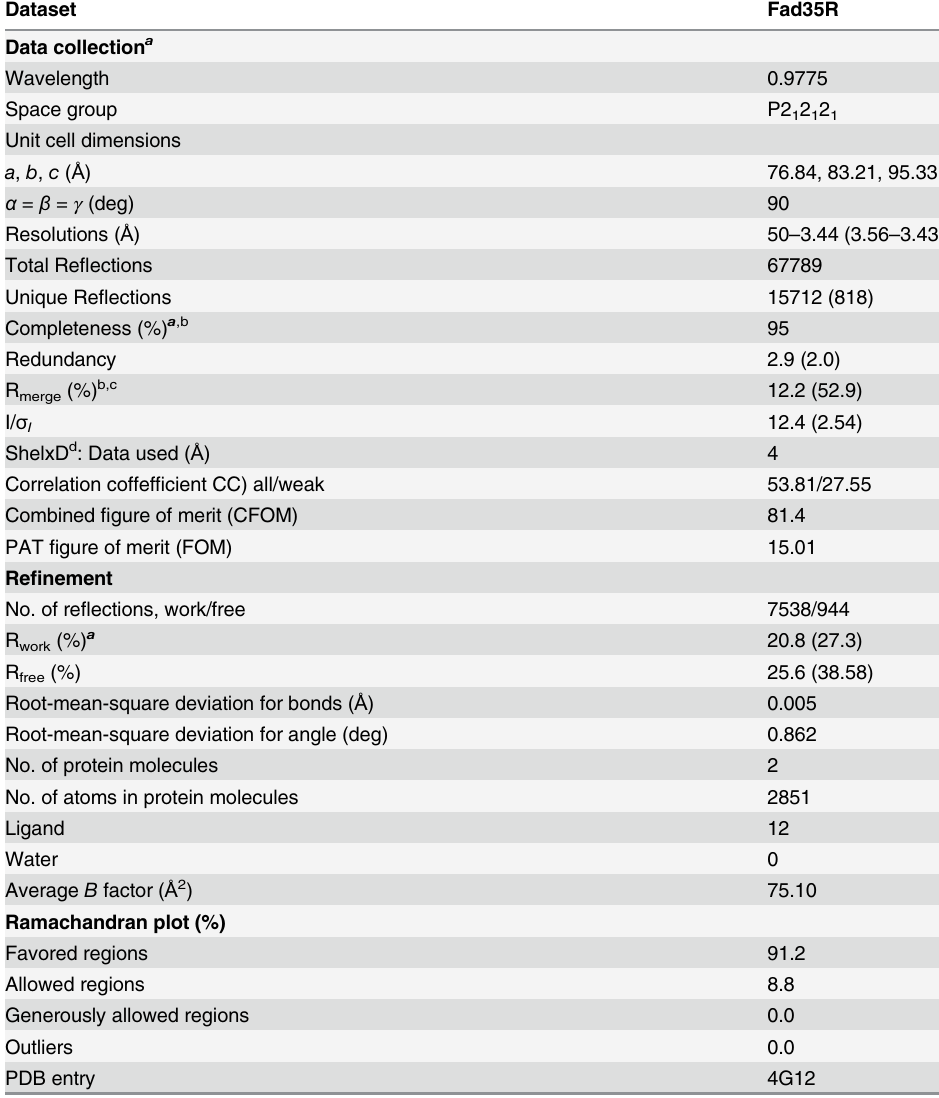
Table 1. Data collection and refinement